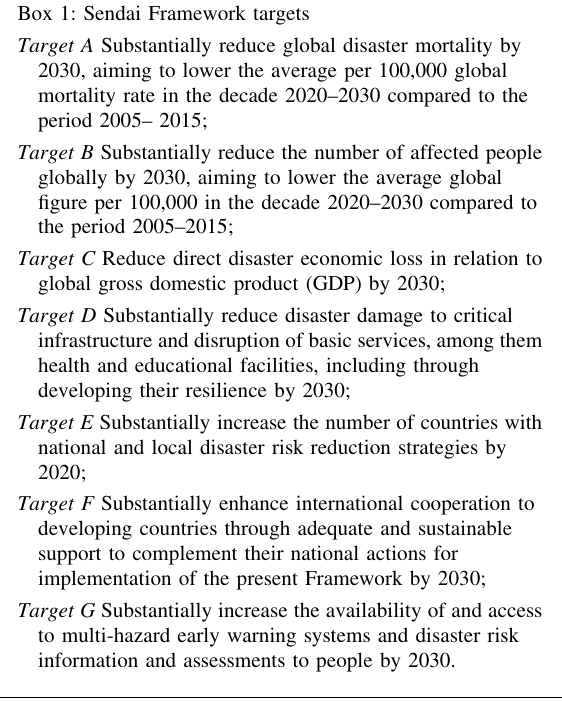
Fig. 1 Summary of UN engagement in disasters and the UN adopted frameworks from the 1960s to 2015. Source Adapted from UNISDR